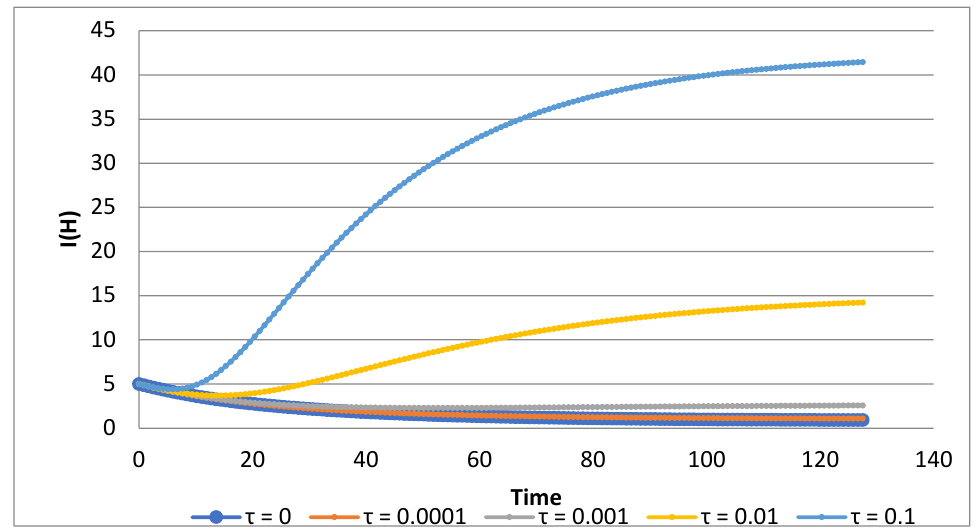
Figure 9. The figure shows the effect of the decaying vaccination for different decay rates for the graphs of human infective population I H ( t ) if 98% of the susceptibles are vaccinated.